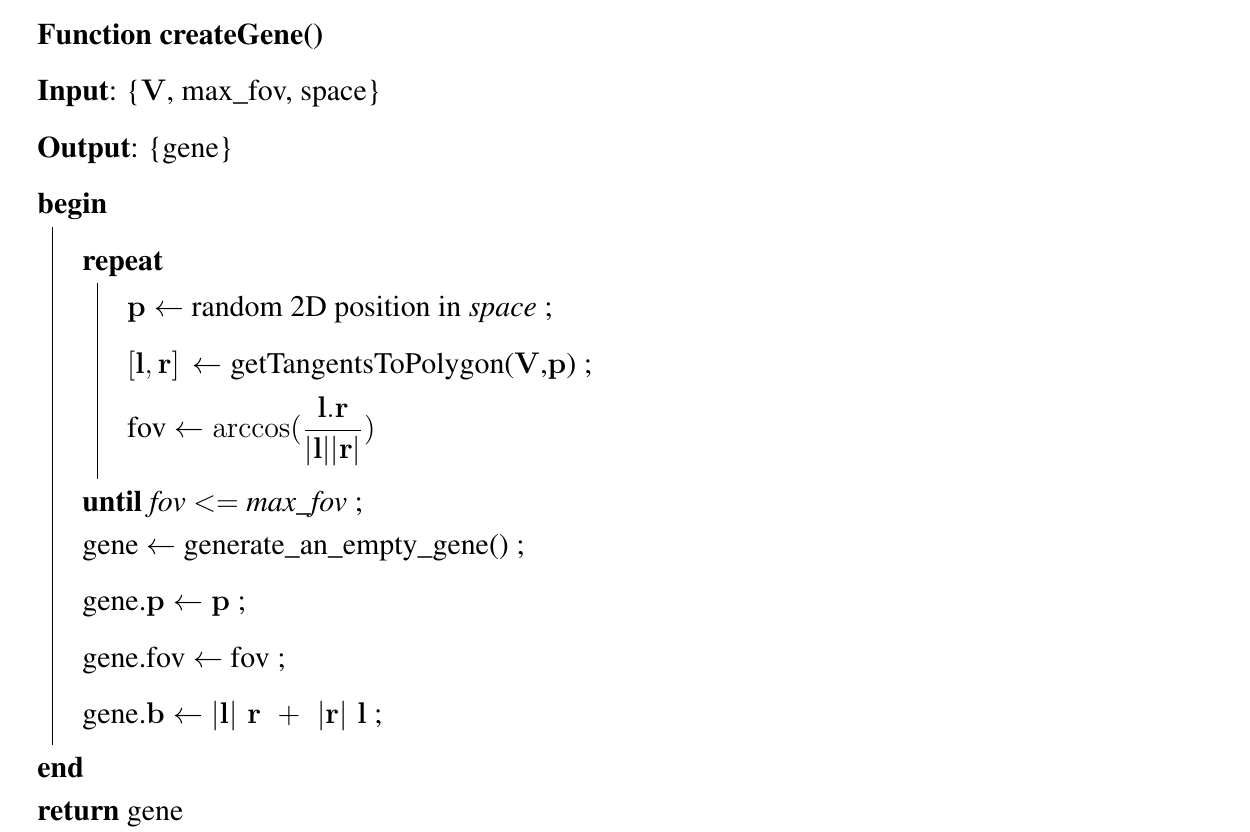
ALGORITHM 2 : Algorithm to generate a valid gene. V is the matrix of vertices of the